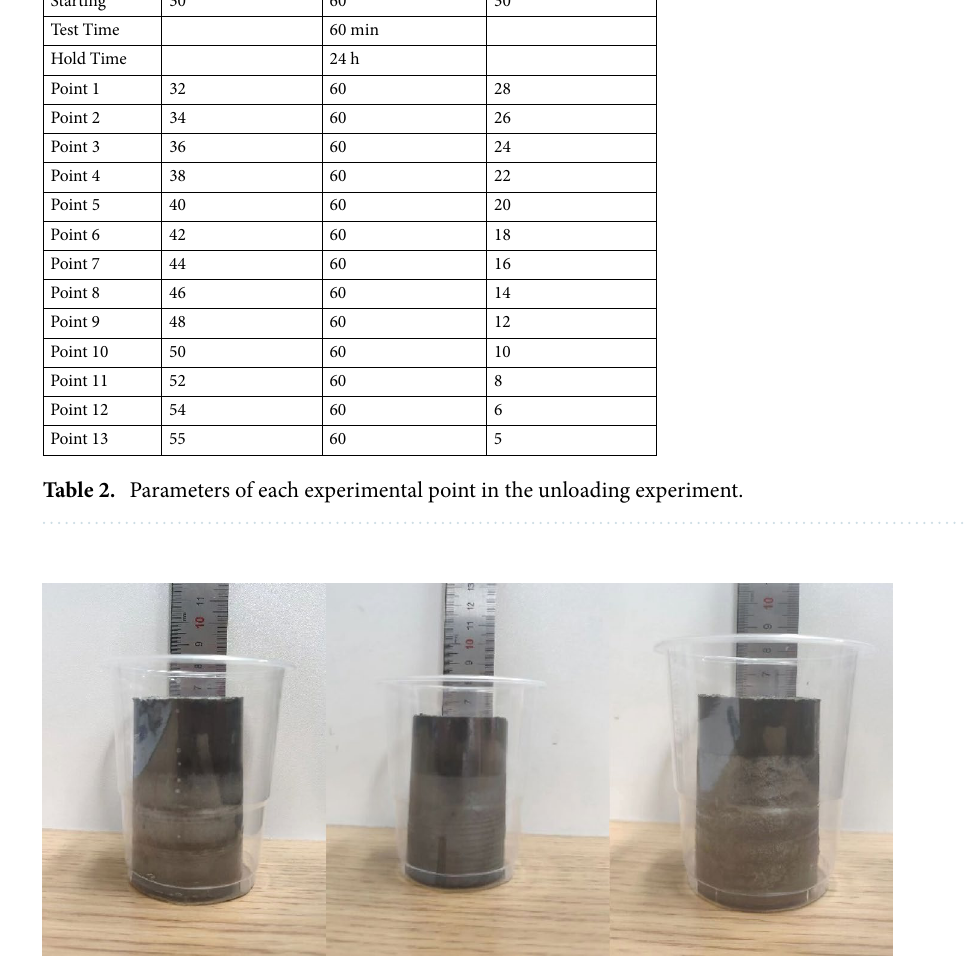
Figure 7. Rock after soil